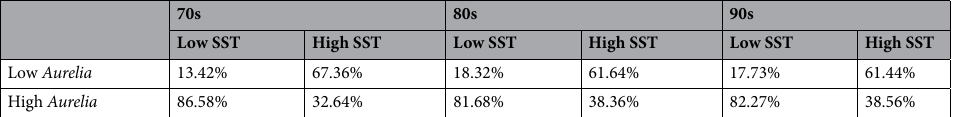
Table 4. Probability of Aurelia being in a low or high abundance state (excluding zero counts) given either low or high sea surface temperature over the three decades.